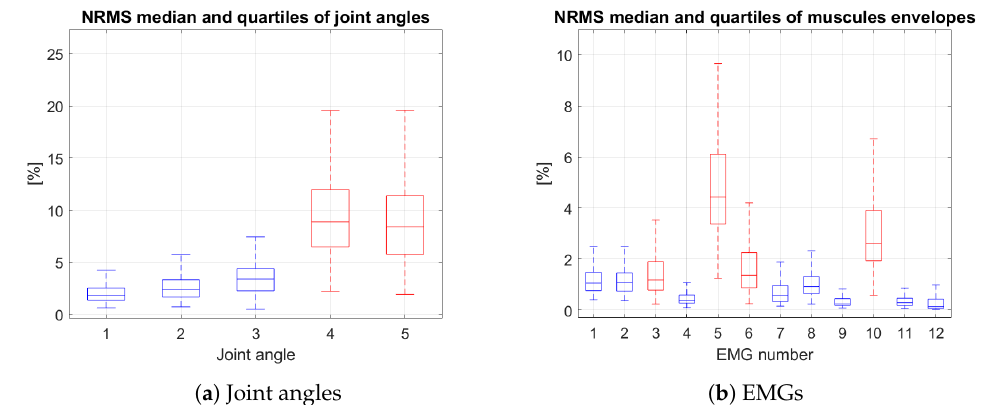
Figure 5. Normalized RMS Error computed for each DoF (measured DoFs in blue, non-measured DoFs in red).